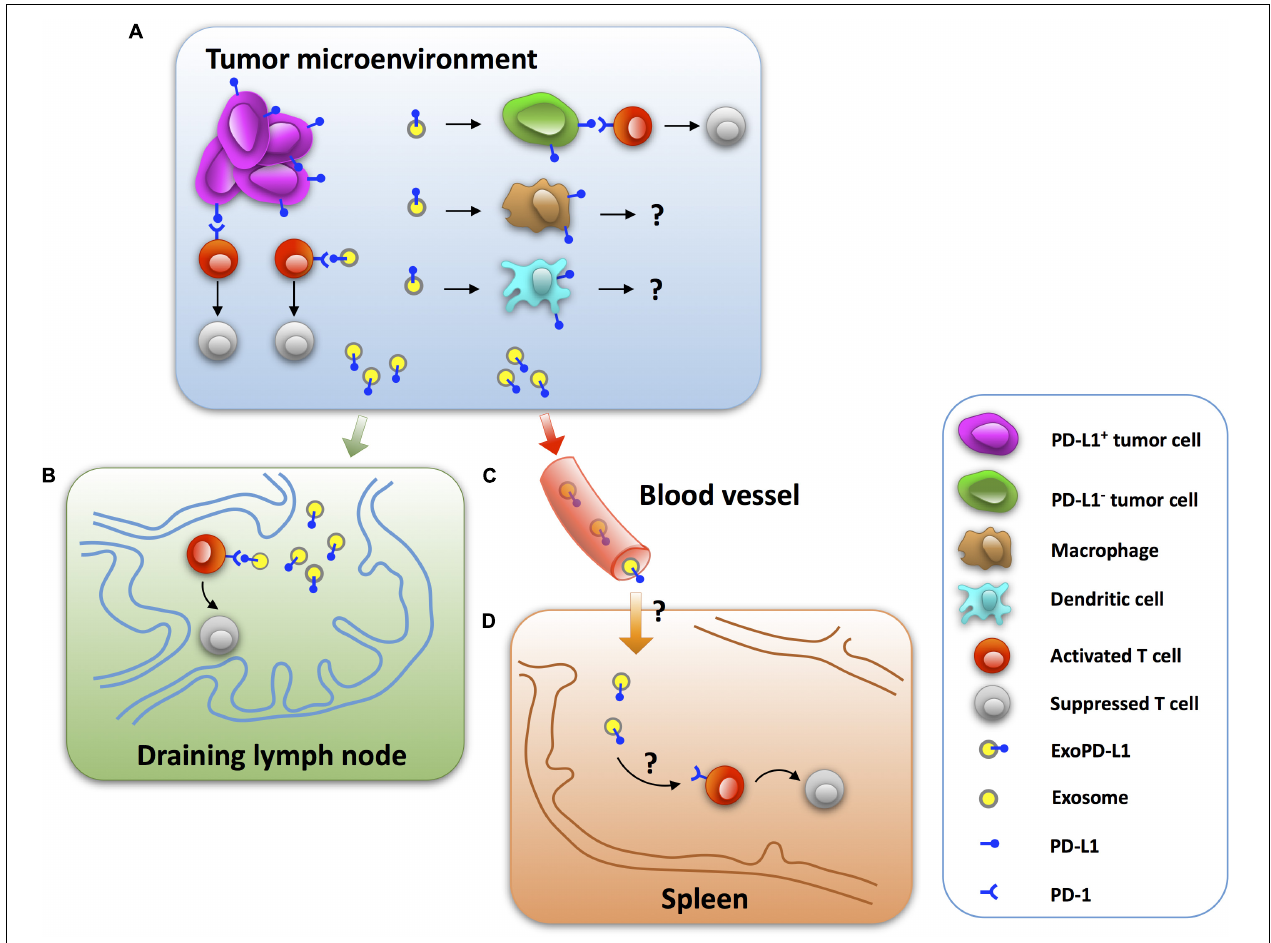
FIGURE 1 | The mechanisms by which tumor ExoPD-L1 induce immunosuppression. (A) ExoPD-L1 originating from tumor cells induces T cell dysfunction in the tumor microenvironment by directly ligating to PD-1 on T cells as well as stationing on PD-L1-negative tumor cells, while its immunoregulatory effect remains intact. ExoPD-L1 also migrates to macrophages and dendritic cells, but the potential effects remain unknown. (B) ExoPD-L1 is able to leave tumor foci and enter the draining lymph node to mediate T cell suppression. (C) ExoPD-L1 can enter and circulate in the blood. (D) ExoPD-L1 inhibits the immune response in spleen and decreases spleen